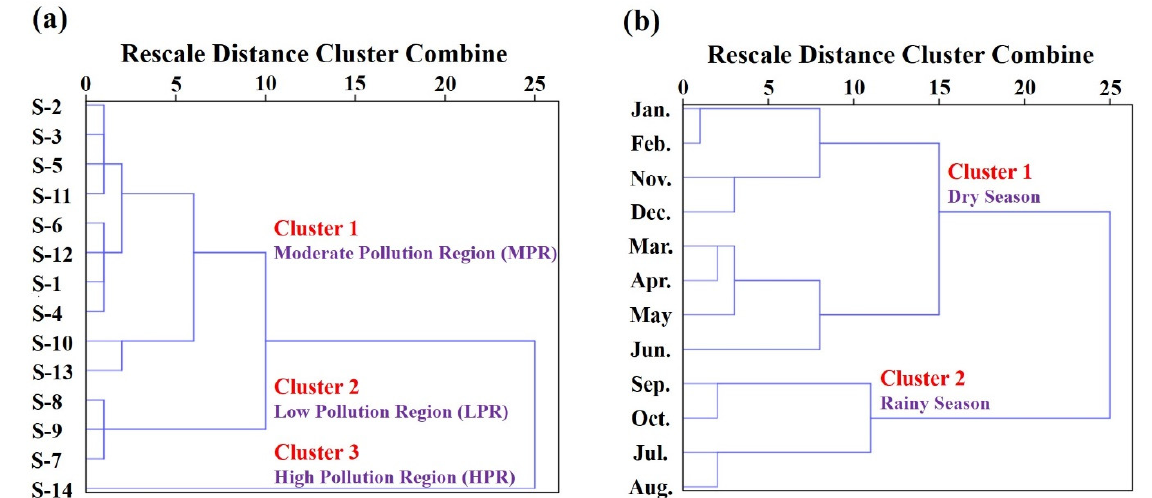
Figure 5. Dendrogram showing hierarchical ( a ) spatial and ( b ) temporal clustering according to Ward’s method with Euclidean distance.